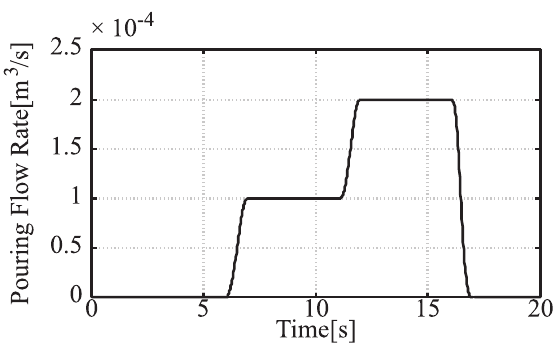
Figure 10. Reference pouring flow rate. The simulation results obtained without any disturbances are presented in Figure 11, where (a) indicates the input command applied to the motor for tilting the ladle, and (b) and (c) indicate the angular velocity and the tilting angle of the ladle, respectively.